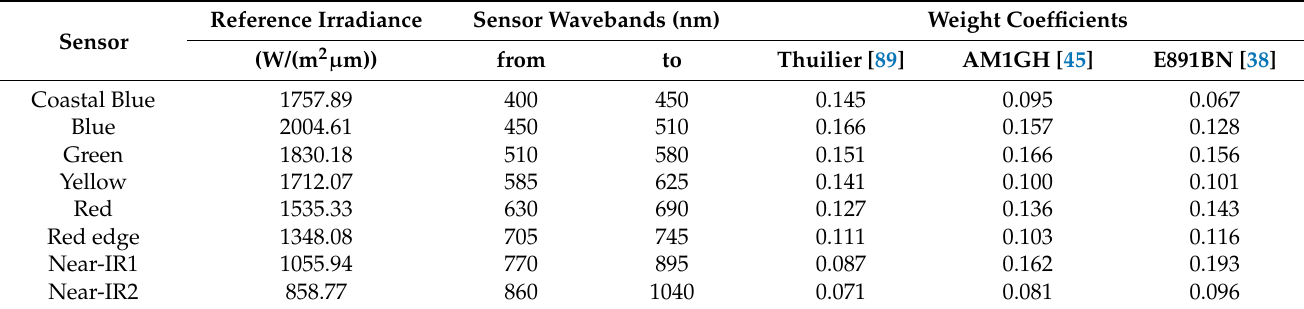
Table 5. Satellite sensors and weight coefficients matching selected solar spectra.